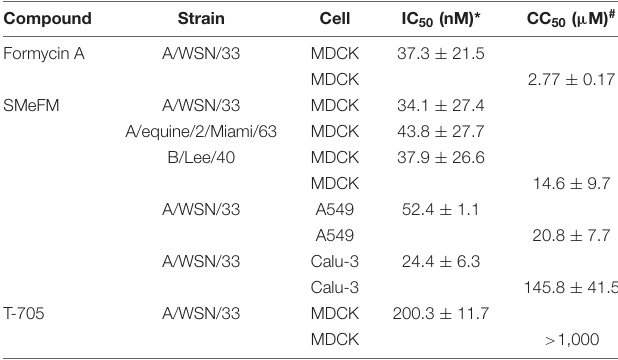
TABLE 1 | IC 50 and CC 50 of formycin A, SMeFM, and T-705 for the propagation of influenza virus strains and for cell viability. Compound Strain